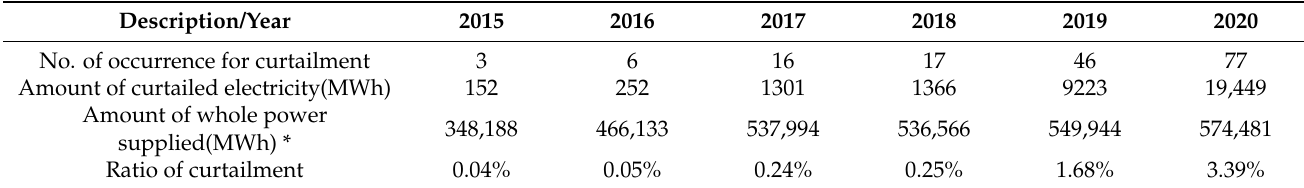
Table 1. Frequency and amount of curtailment on Jeju Island